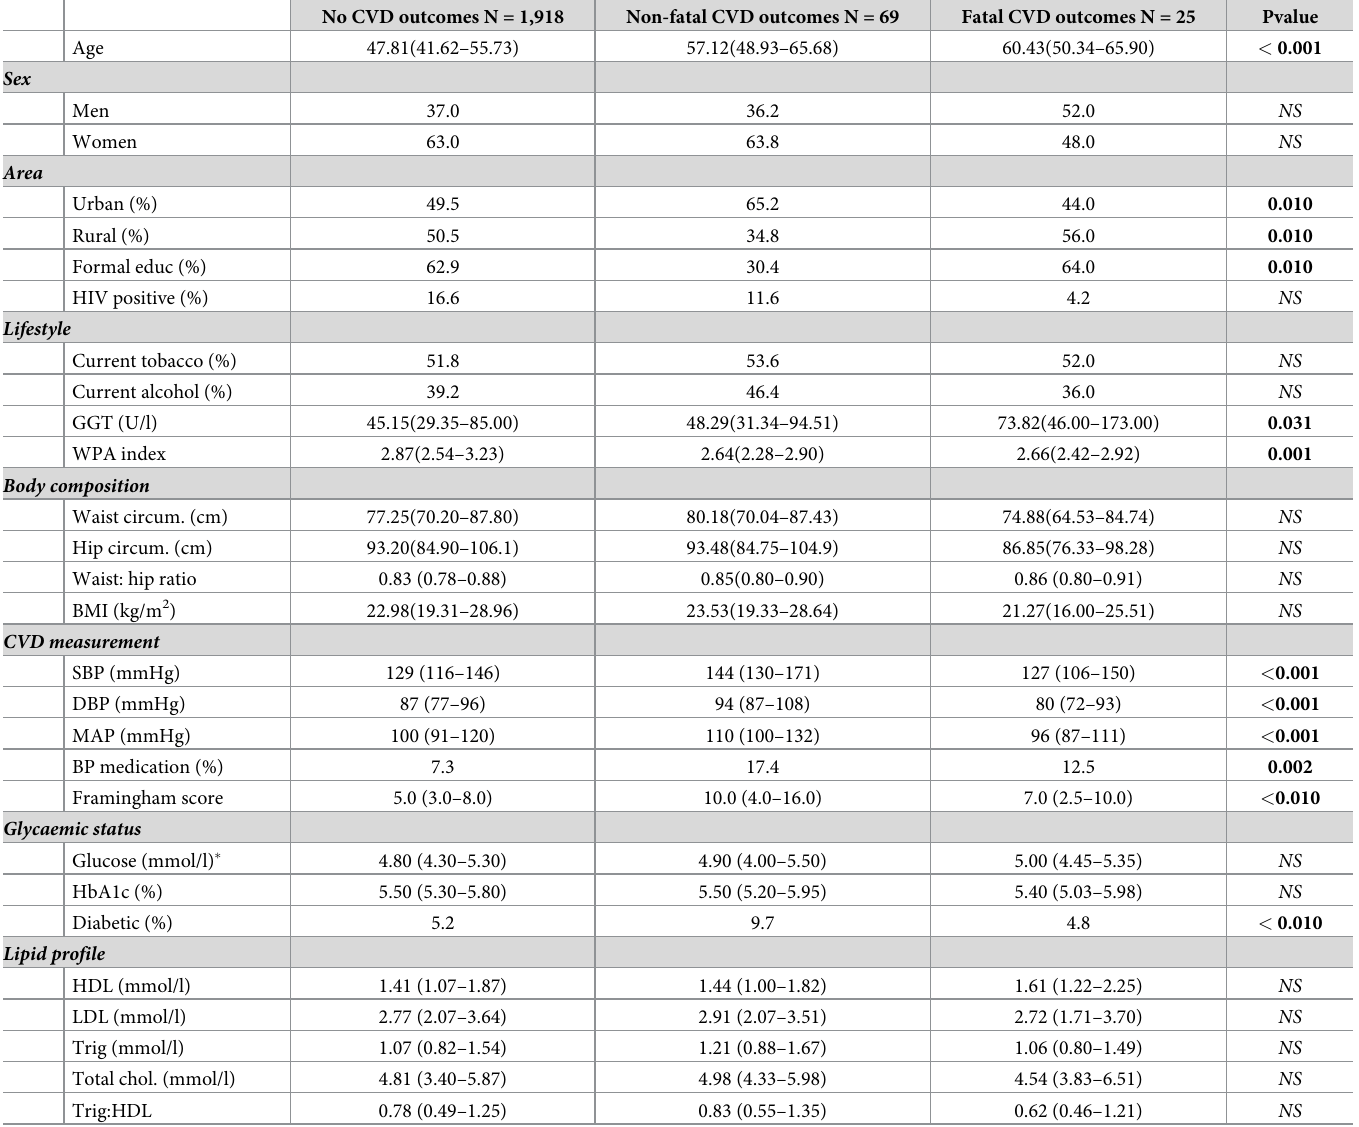
Table 1. Baseline demographic characteristics of study